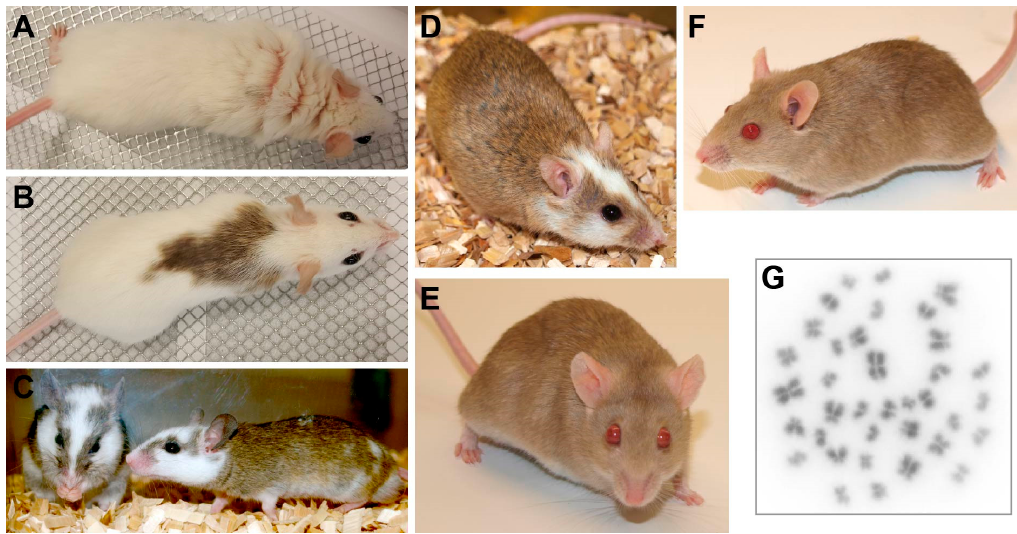
Figure 2. The multimammate mouse Mastomys coucha . ( A – D ) Black-eyed Mastomys coucha with different coat colors. ( E , F ) Chamois-colored red-eyed Mastomys coucha used at the DKFZ (derived from the GRA-Giessen strain). ( G ) Metaphase chromosome spread obtained from a Mastomys coucha splenocyte (2 n = 36; 630 ×